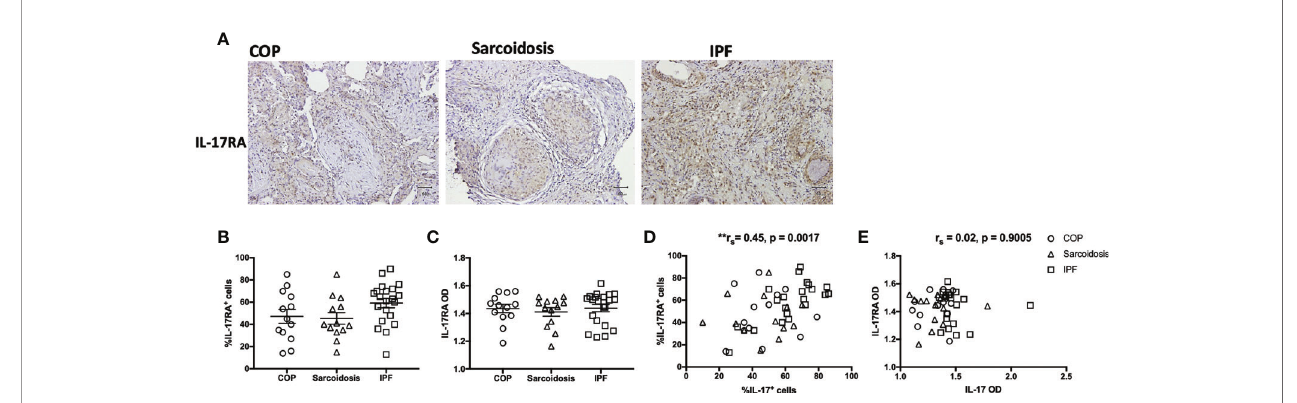
FIGURE 2 | IL-17RA expression in ILD lungs. (A) Representative immunohistochemical image of lung specimens from subjects with COP, sarcoidosis and IPF. Magni fi cation ×200. (B, C) Immunohistochemical staining showed no signi fi cant difference in IL-17RA expression amongst lung specimens from patients with COP, sarcoidosis and IPF. (D, E) The correlation between IL-17RA expression and IL-17 expression in ILDs. IL-17, interleukin-17; IL-17RA, interleukin-17 receptor A; IPF, idiopathic pulmonary fi brosis; COP, cryptogenic organizing pneumonia; OD, opacity density score; **p < 0.01.